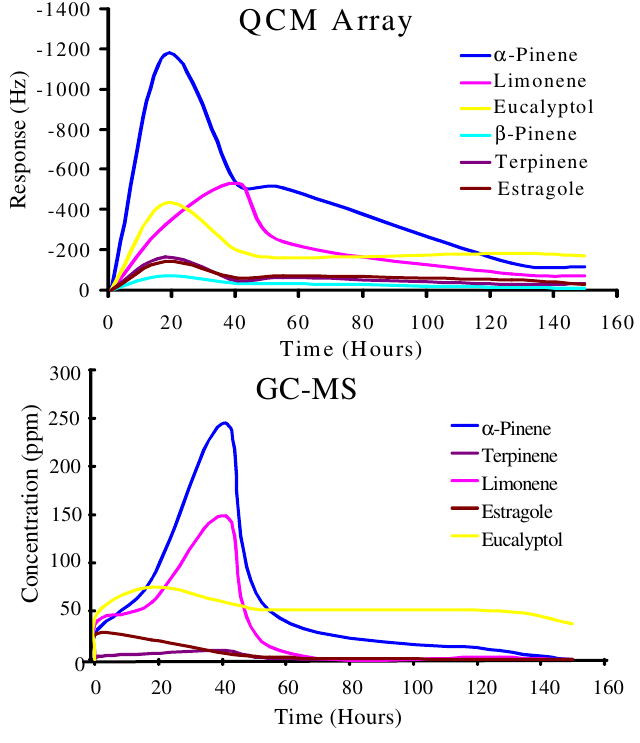
Figure 6. QCM array and GC-MS comparison of terpenes from fresh